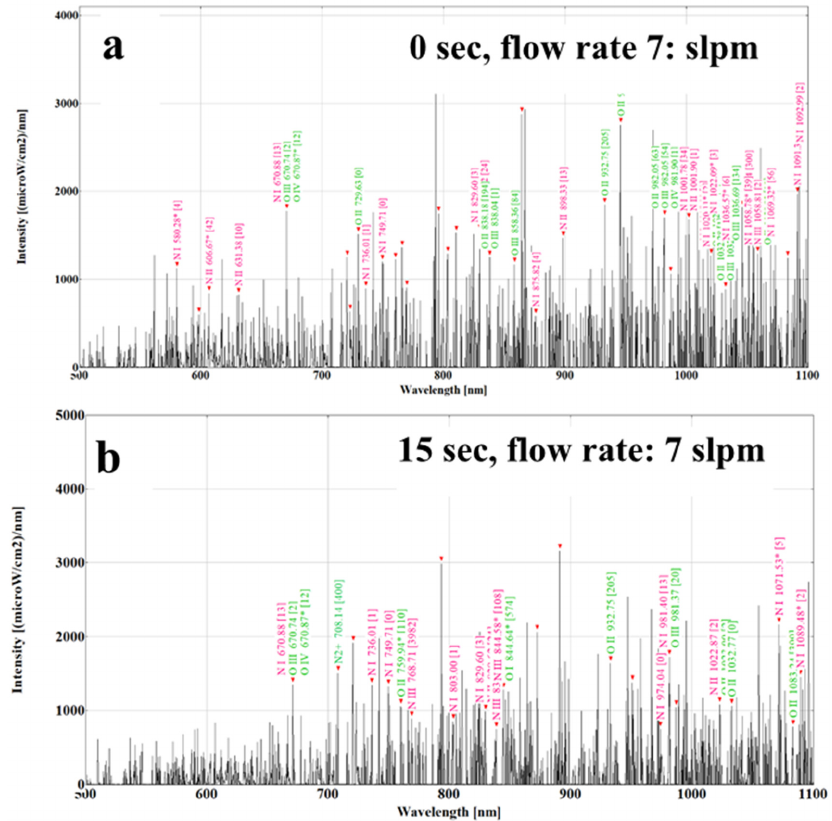
Figure 3. Intensity vs. wavelength for oxygen and nitrogen species generated by plasma at ( a ) 0 s and ( b ) 15 s with flow rate 7 SLPM. Tables 1 and 2 summarize the parameters of RONS at 0 s and 15 s, respectively, in- cluding wavelengths, intensity, ionic species excited state (single/multiple), identified lines, relative intensity, energy (lower/upper), transition state (lower/upper), and quan- tum number (lower/upper). In these tables, N I, N II, N III and O I, O II, OIII, OIV debnote RNS and ROS, respectively. Table 1. Reactive species identified via OES at 7 slpm at 0 s, with 30 RNS and 18 ROS. Wave-Length (nm)